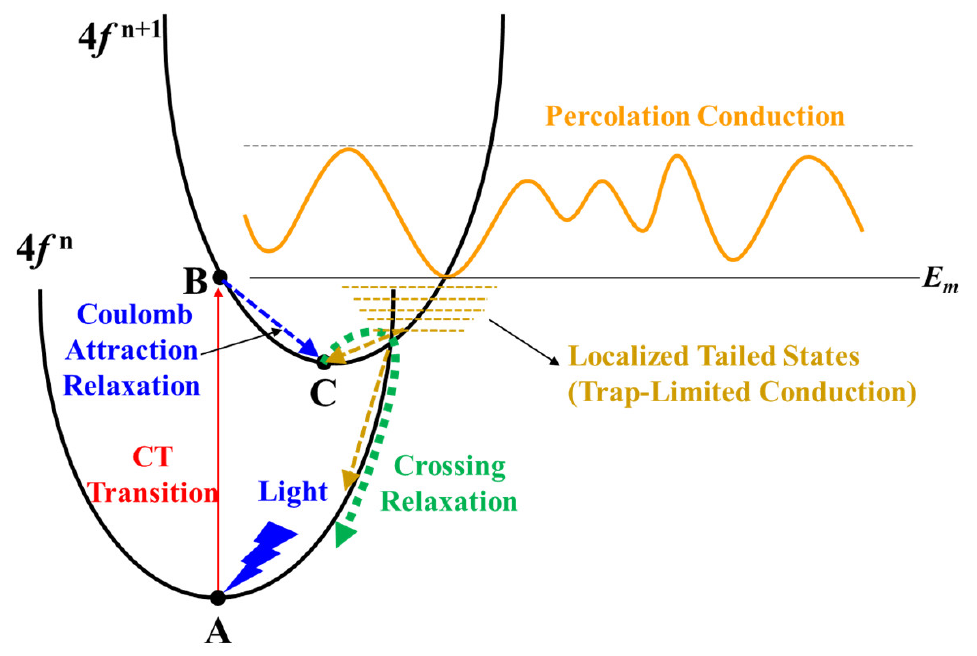
Figure 6. Illustration of the CT transition process in Pr 4+ /Tb 4+ doped In 2 O 3 .